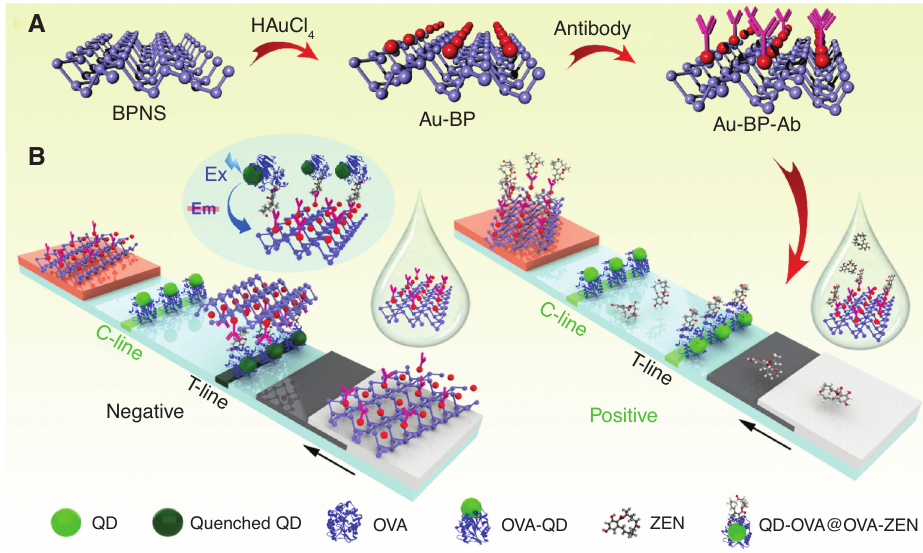
Figure 1: Schematic of the developed black phosphorus (BP)-Au nanocomposite-based fluorescent quenching immunochromatographic sensor